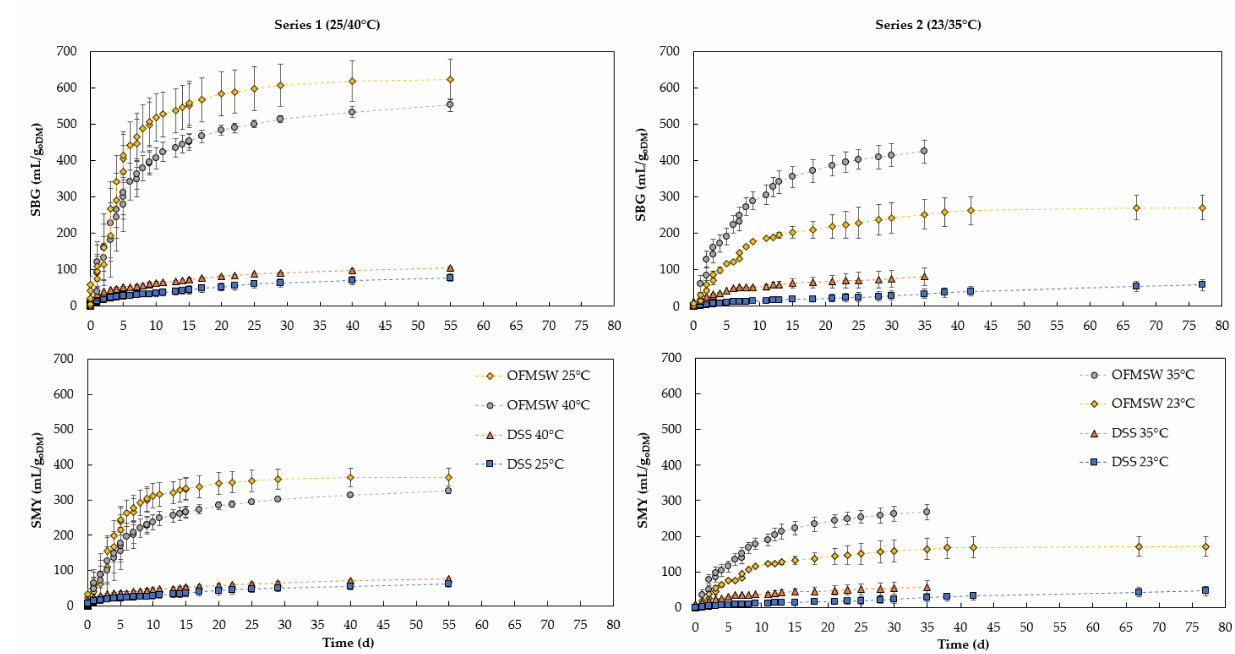
Figure 2. Specific biogas yield (SBG) and methane yield (SMY) for the organic fraction of municipal solid waste (OFMSW) alone and the digested sewage sludge (DSS) alone; mean values ± standard deviation (n = 2 for DSS, n = 4 for OFMSW) based on organic dry matter (oDM), gas volume at 1013 hPa, 0 ◦ C.